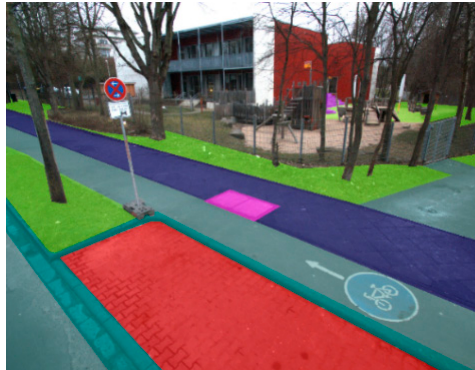
Figure 6. Manual surface segmentation (green: grass, red: small paving, blue: large paving, grey: Figure 4. Manual surface segmentation (green: grass, red: small paving, blue: large paving, grey: Figure 4. Manual surface segmentation (green: grass, red: small paving, blue: large paving, grey: asphalt: magenta: manhole cover, cyan: curbstone). asphalt: magenta: manhole cover, cyan: curbstone). asphalt: magenta: manhole cover, cyan: curbstone). Figure 4. Manual surface segmentation (green: grass, red: small paving, blue: large paving, grey: Figure 4. Manual surface segmentation (green: grass, red: small paving, blue: large paving, grey: Figure 4. Manual surface segmentation (green: grass, red: small paving, blue: large paving, grey: Figure 4. Manual surface segmentation (green: grass, red: small paving, blue: large paving, grey: Figure 4. Manual surface segmentation (green: grass, red: small paving, blue: large paving, grey: Figure 4. Manual surface segmentation (green: grass, red: small paving, blue: large paving, grey: Figure 4. Manual surface segmentation (green: grass, red: small paving, blue: large paving, grey: Figure 4. Manual surface segmentation (green: grass, red: small paving, blue: large paving, grey: Figure 4. Manual surface segmentation (green: grass, red: small paving, blue: large paving, grey: asphalt: magenta: manhole cover, cyan: curbstone). asphalt: magenta: manhole cover, cyan: curbstone). asphalt: magenta: manhole cover, cyan: curbstone). asphalt: magenta: manhole cover, cyan: curbstone). asphalt: magenta: manhole cover, cyan: curbstone). asphalt: magenta: manhole cover, cyan: curbstone). asphalt: magenta: manhole cover, cyan: curbstone). asphalt: magenta: manhole cover, cyan: curbstone). asphalt: magenta: manhole cover, cyan: curbstone).